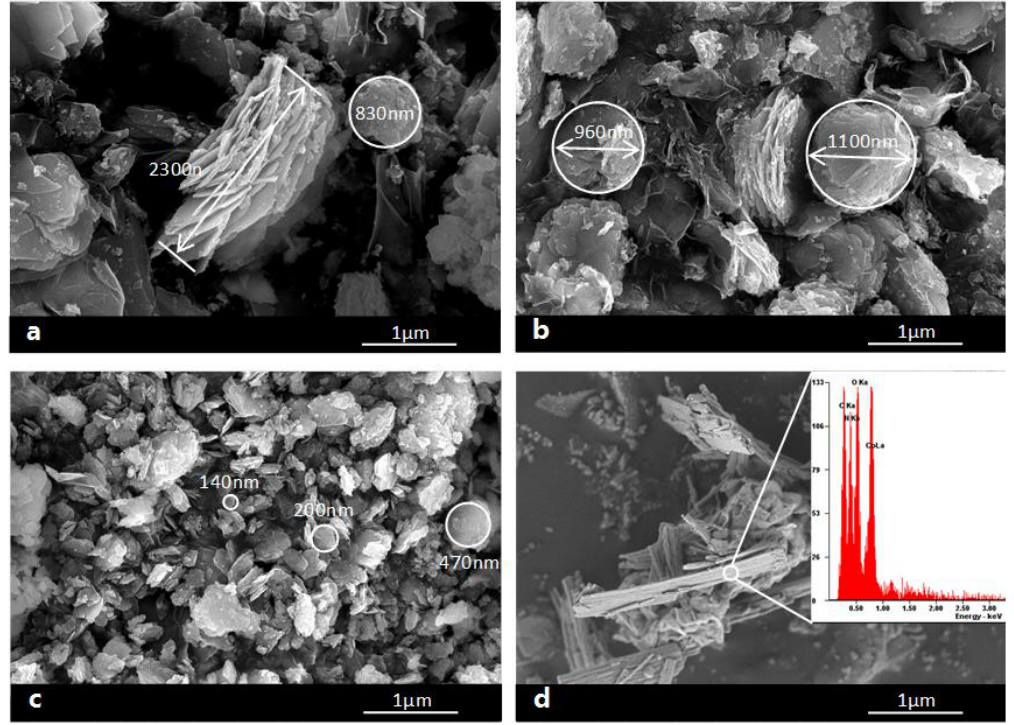
Figure 6. SEM Photo of catalysts with different amounts of nitrogen. ( a ) LC-SH-1; ( b ) LC-SH-2; ( c ) LC-SH-3; and, ( d ) LC-SH-4. Table 2. BET results of catalysts with different amounts of nitrogen.